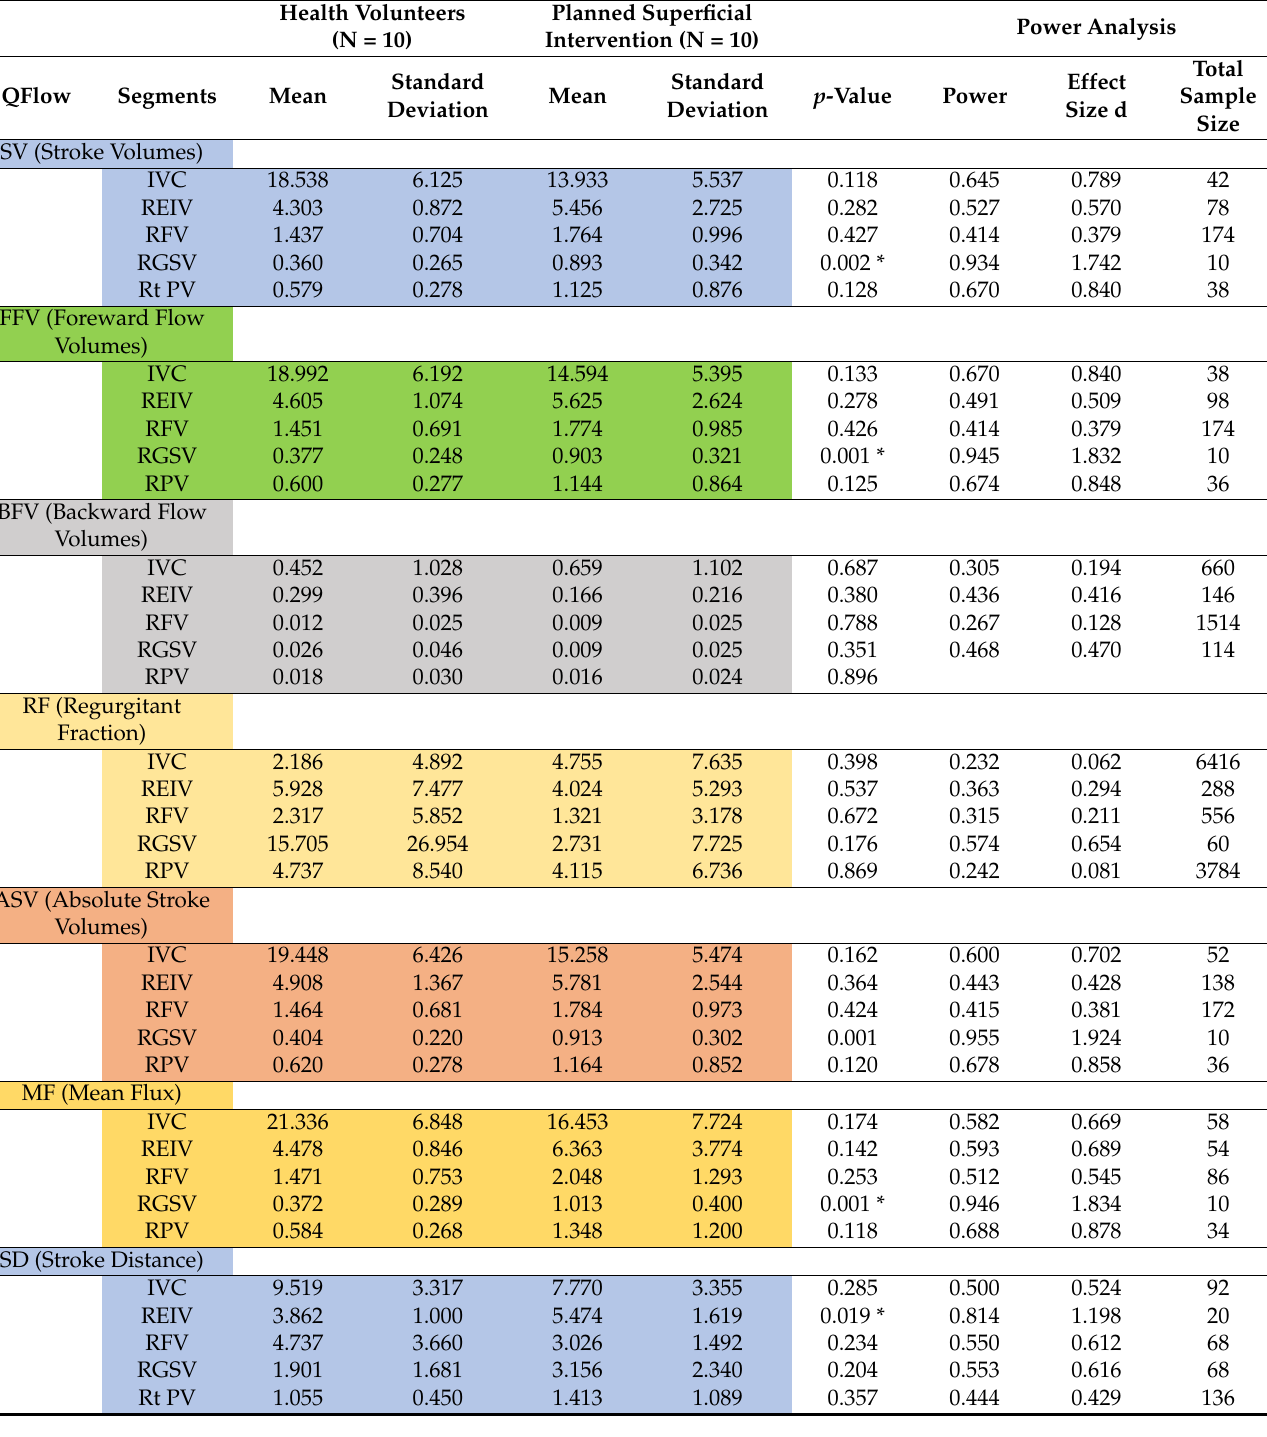
Table 5. Comparison of the QFlow parameters between the right legs of health controls and the right legs planning for truncal